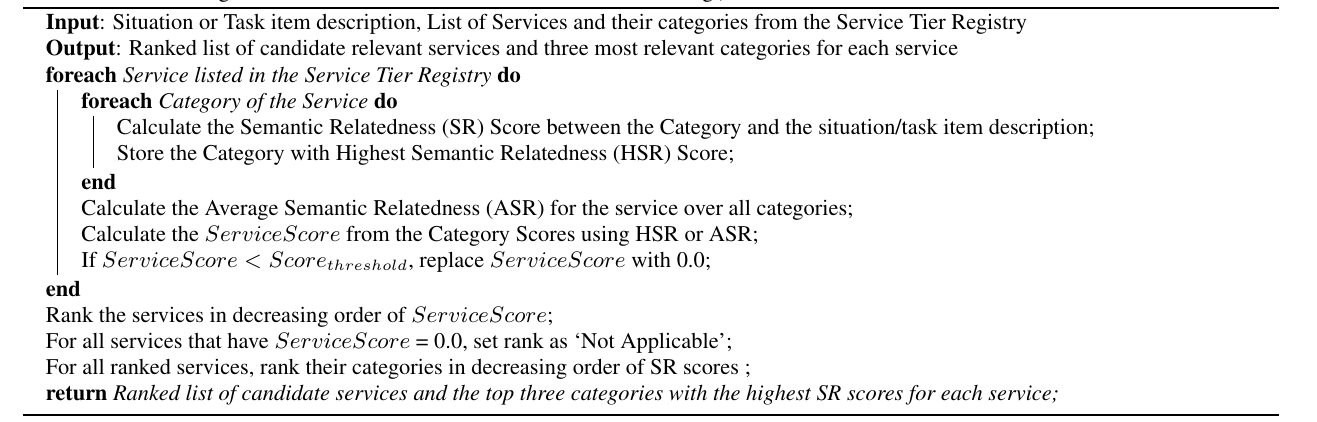
Algorithm 1: Base Relevant Services and Information Discovery and Ranking algorithm (The algorithm can vary depending on the method of calculating semantic relatedness and the mechanisms for ranking.)